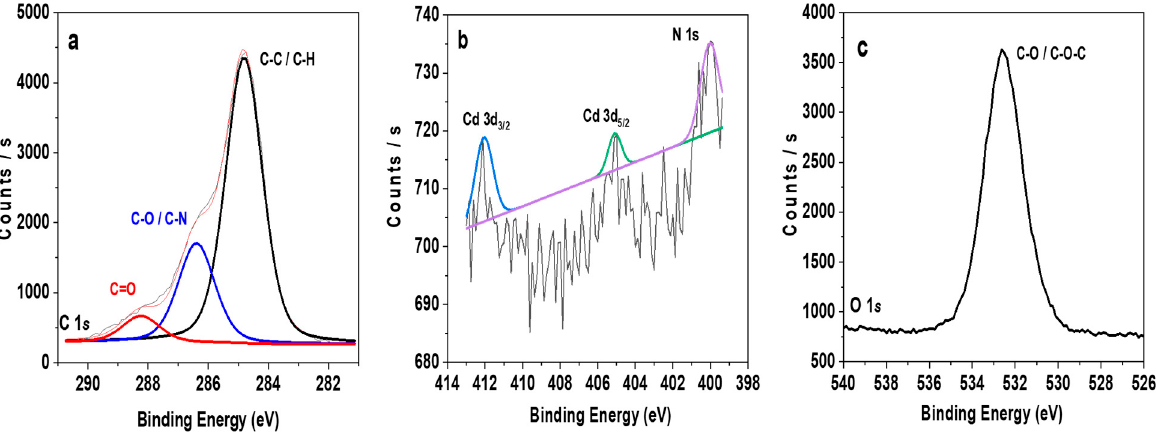
Figure 5. XPS core level spectra of RC-4/CdSe QDs-DAB 5 film: ( a ) C 1 s ; ( b ) Cd 3 d and N 1 s ; ( c ) O 1 s